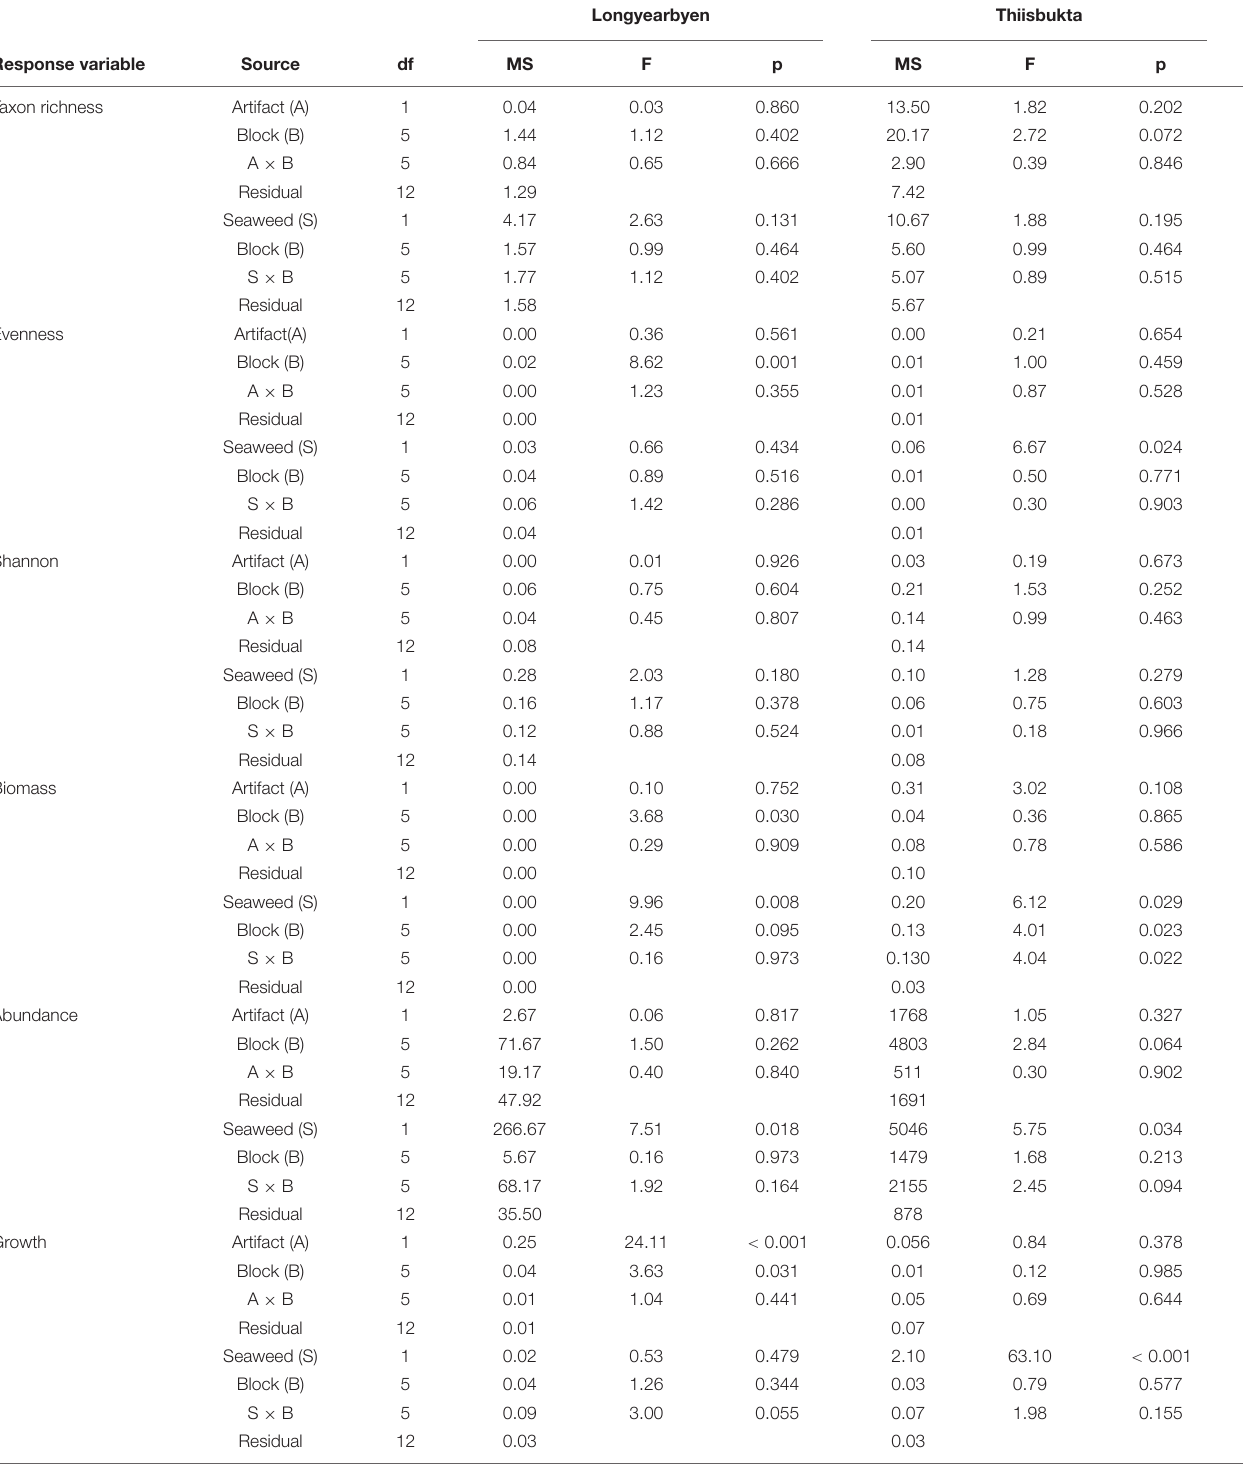
TABLE A1 | Summary of ANOVA results on separate and interactive effects of detached seaweeds (fixed) and blocks (random) at the end of the experiment. Longyearbyen